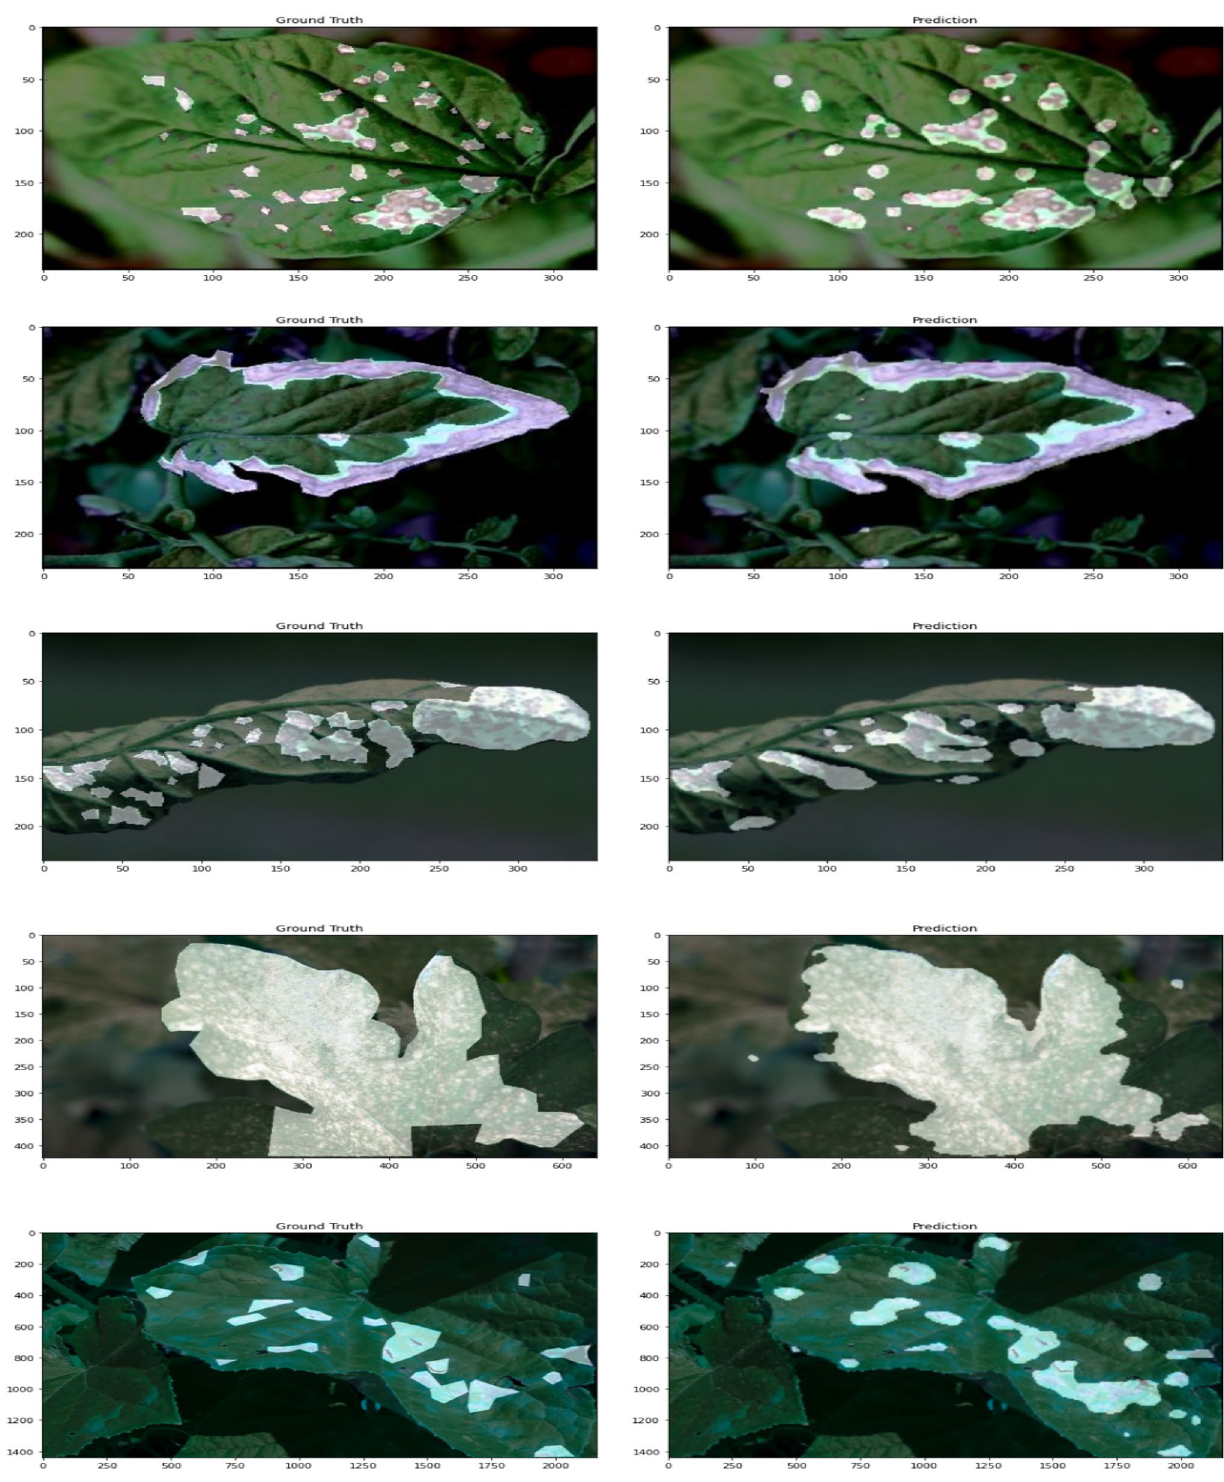
Fig. 4 Example of results for semantic segmentation obtained by SegNet